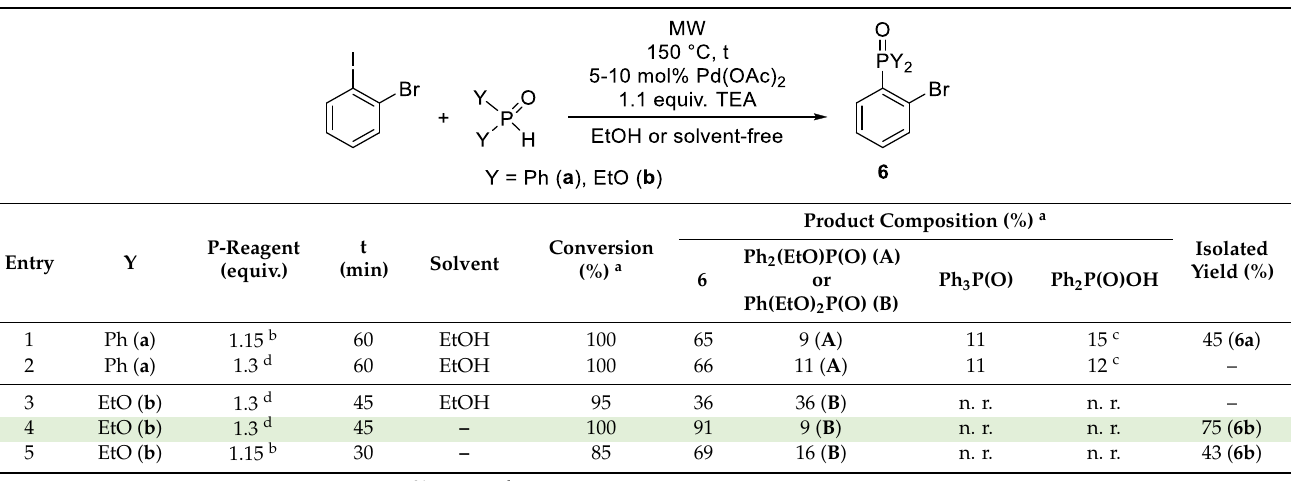
Table 8. P–C coupling reactions of 1-bromo-2-iodobenzene. Table 8. P – C coupling reactions of